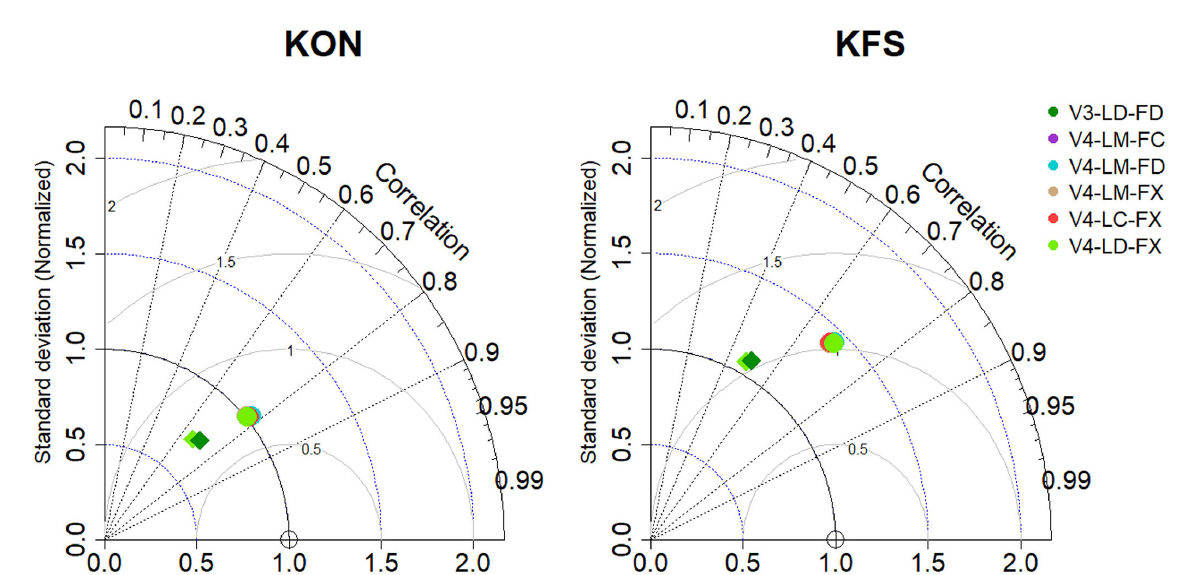
FIGURE2 Taylor diagrams for comparing model performance: (circles) latent heat (LE) and (diamonds) gross primary production (GPP) from both KON and KFS sites. The radial distance from the origin is the normalized standard deviation and the correlation coefficient is displayed as the azimuthal position. All statistics are calculated on a daily time scale from 2008 to 2018 and colors represent different models consistent with the color